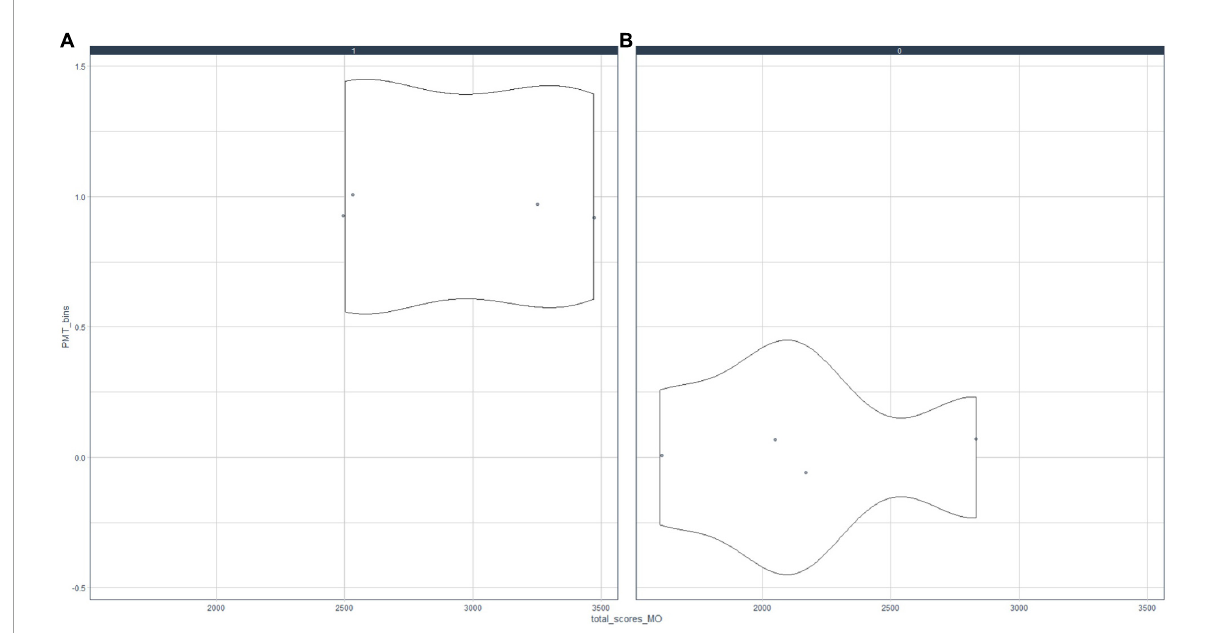
FIGURE1 Relationship between motivation (MO) and teaching (PMT). Association of motivation and teaching indicators; (A) MO = 0, (B) MO =